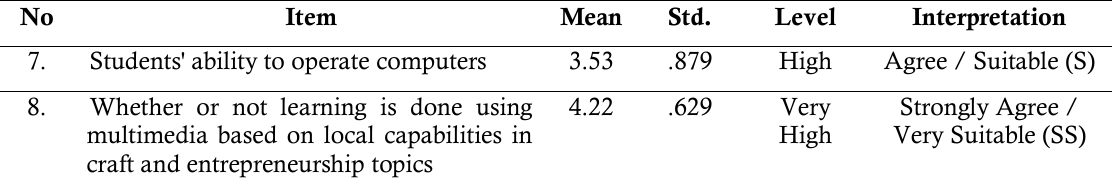
Table 5 . Results of Perception Regarding Multimedia Opportunities for Learning